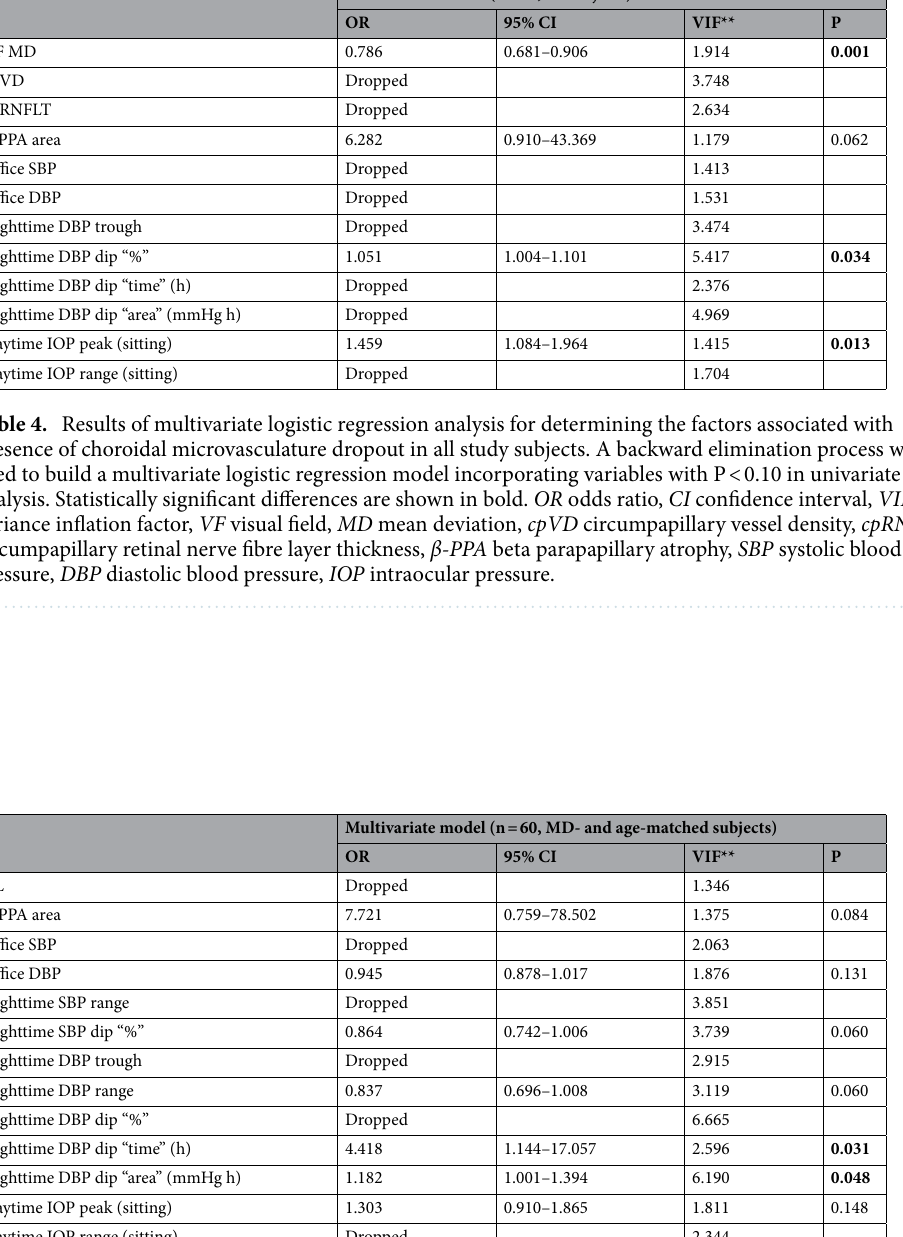
Table 5. Results of multivariate logistic regression analysis for determining the factors associated with the presence of choroidal microvasculature dropout in visual field mean deviation- and age-matched subjects. A backward elimination process was used to build the multivariate logistic regression model incorporating variables with P < 0.10 in univariate analysis. Statistically significant differences are shown in bold. MD mean deviation, OR odds ratio, CI confidence interval, VIF variance inflation factor, AL axial length, β-PPA beta parapapillary atrophy, SBP systolic blood pressure, DBP diastolic blood pressure, IOP intraocular pressure.